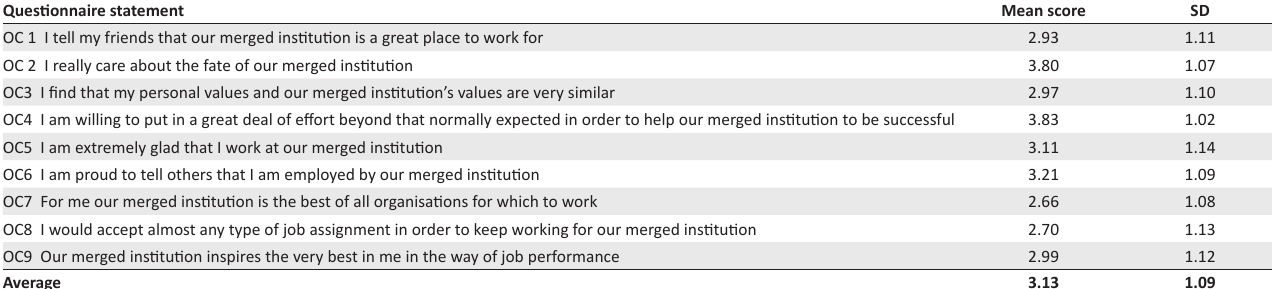
TABLE 3: Organisational commitment: Descriptive statistics.